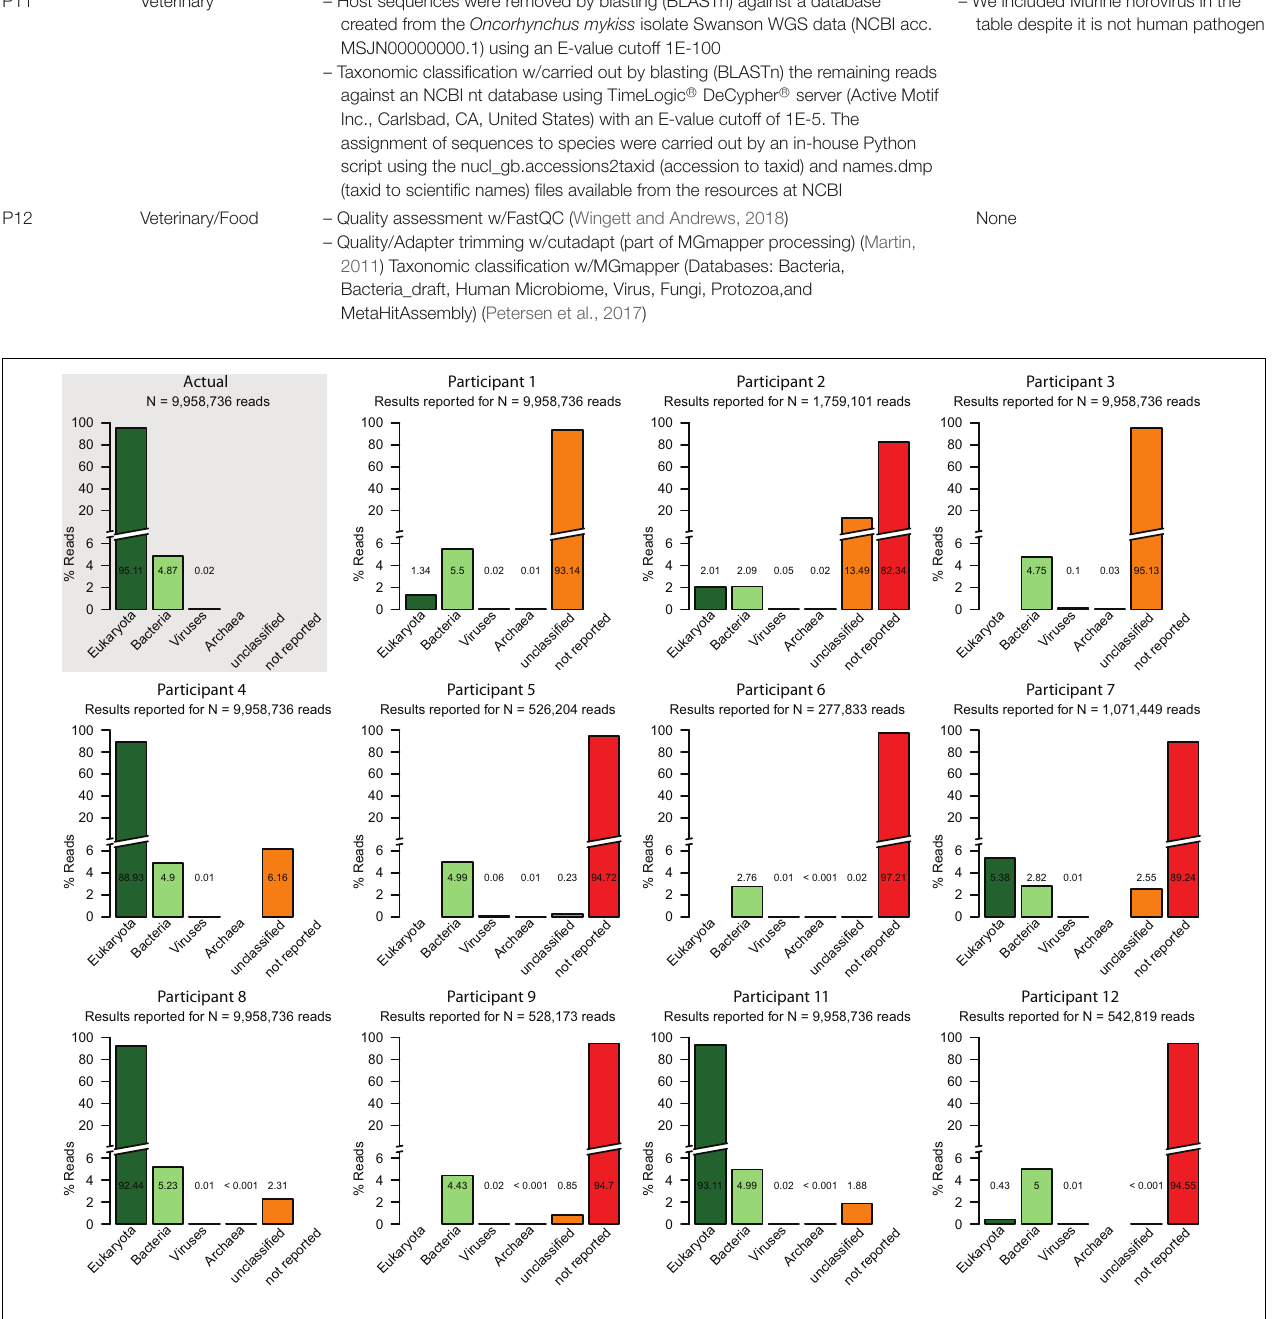
and negative predictive value (except for host sequences)